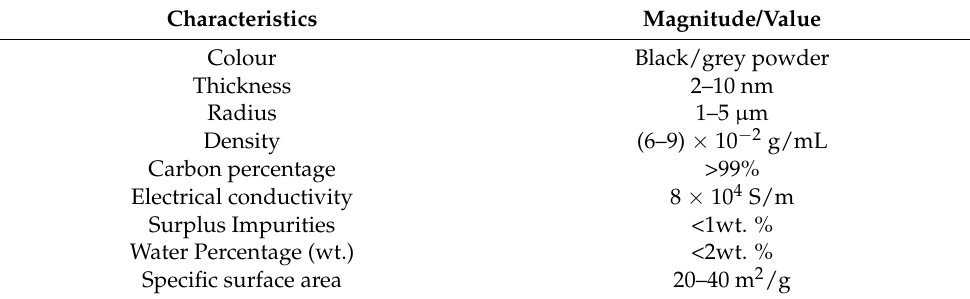
Table 4. Characterization of graphene nanoparticles [45].